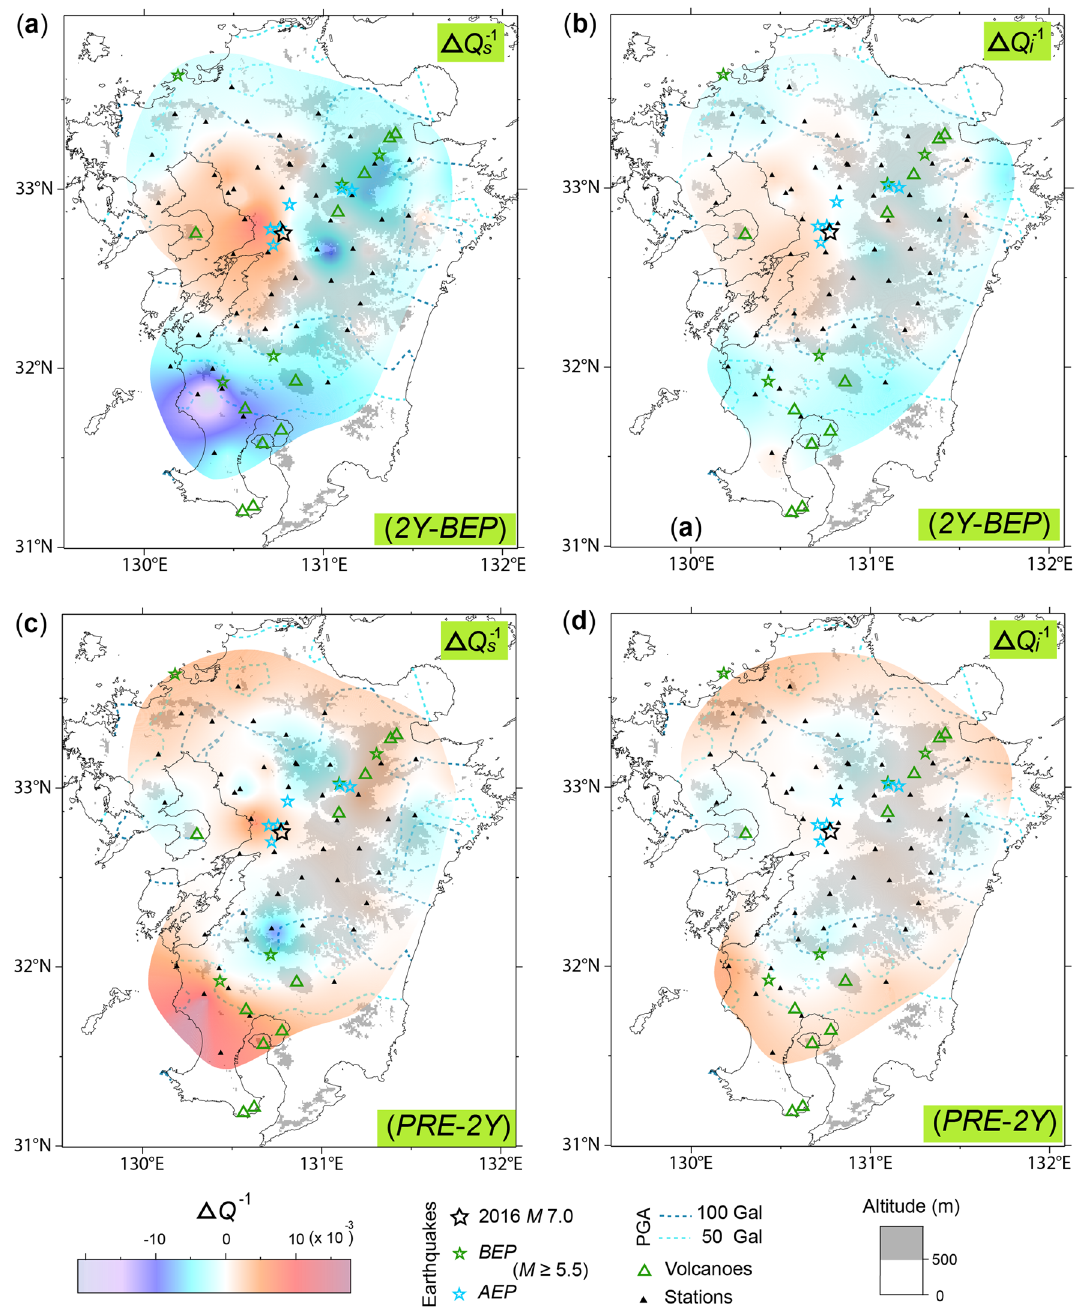
Figure 7. Topographic maps of the Kumamoto earthquake illustrating the difference between the two-year period after the event ( 2Y ) and the BEP ( 2Y-BEP ) for ( a ) the Q s –1 and ( b ) Q i –1 value, respectively. Topographic maps for the values of ( c ) Q s –1 and ( d ) Q i –1 reveal the difference between the present ( PRE ) and the 2Y ( PRE-2Y ), respectively. The styles and symbols are the same as those in Fig.